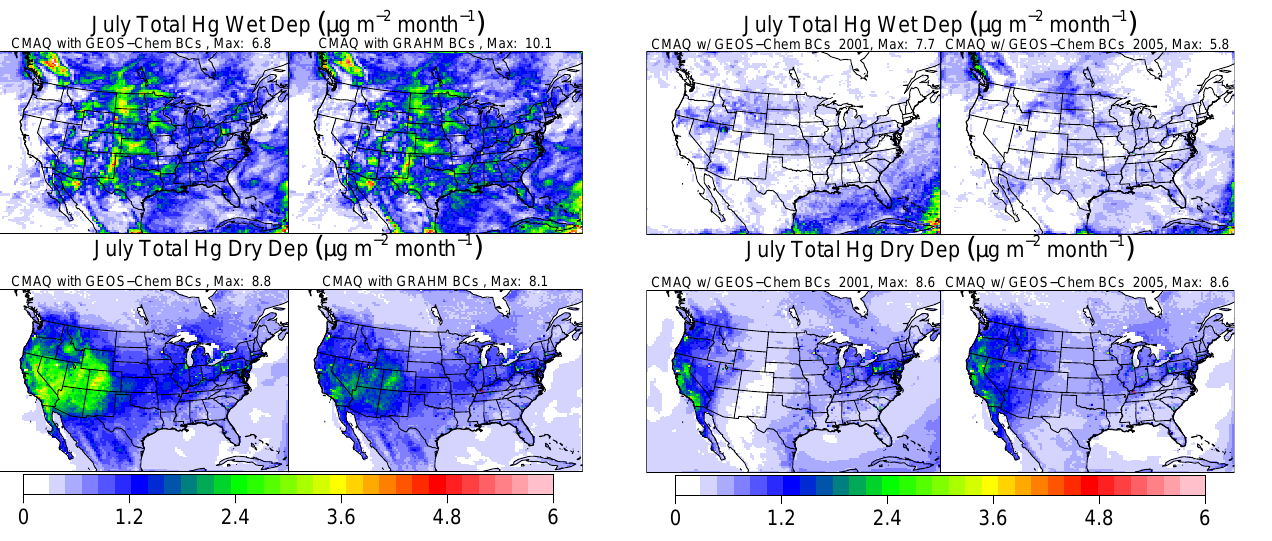
Fig. 6. Simulated mercury deposition from CMAQ runs using boundary conditions derived from GEOS-Chem and GRAHM global model simulations using 2005 meteorology.